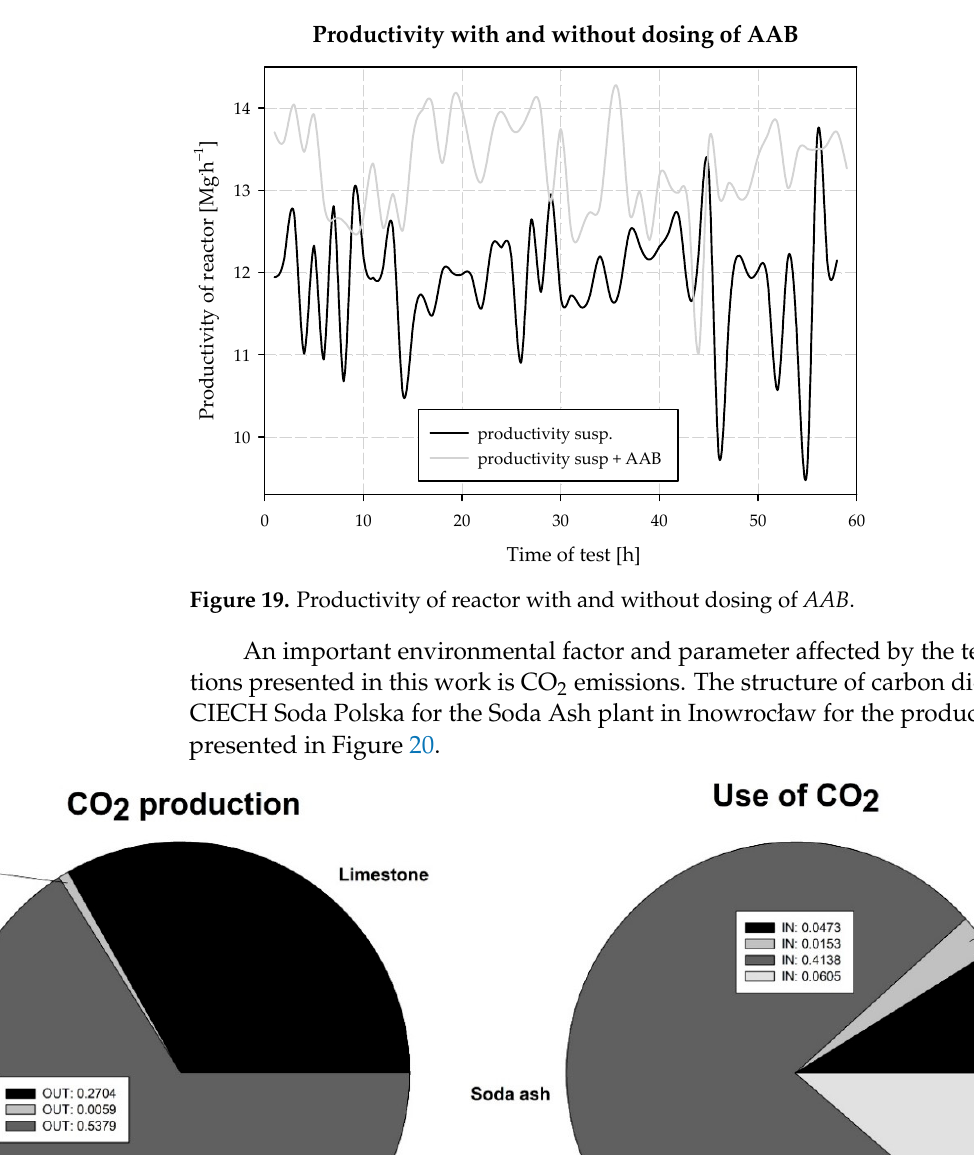
Figure 19. Productivity of reactor with and without dosing of AAB.